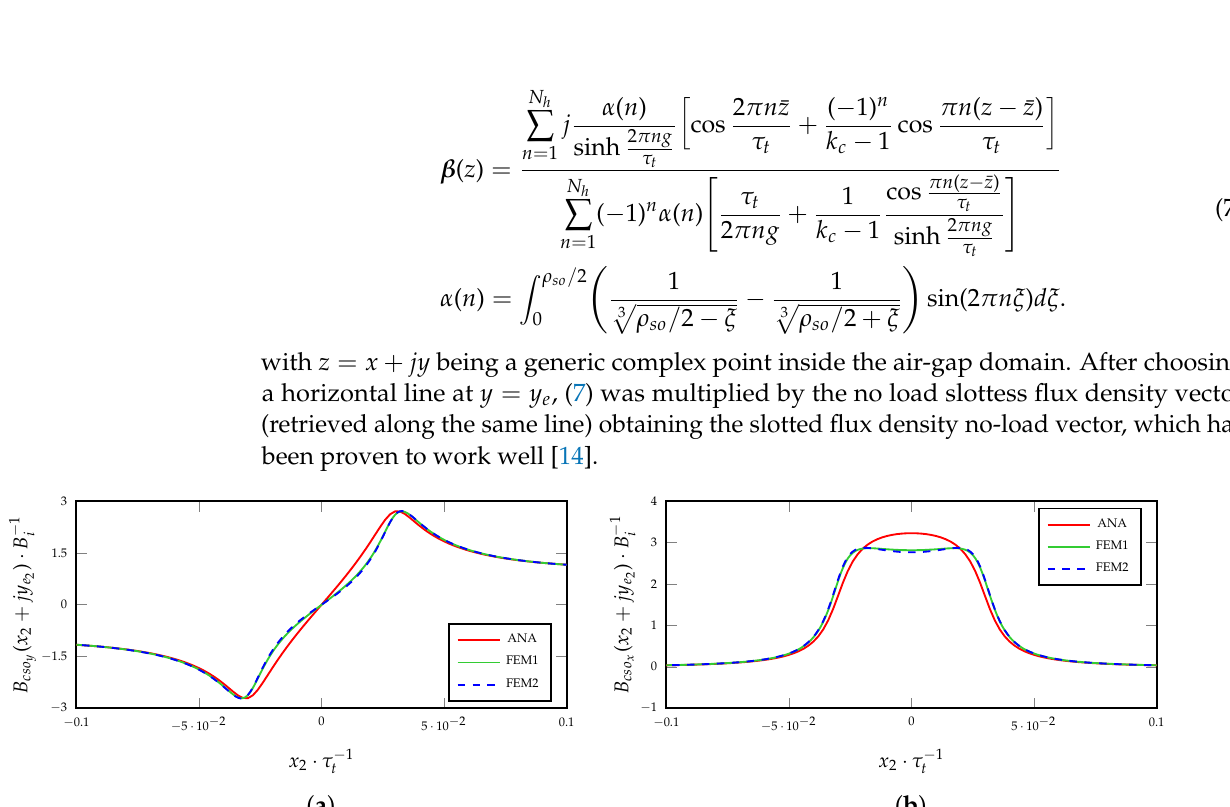
( a ) normal, ( b ) tangential 2